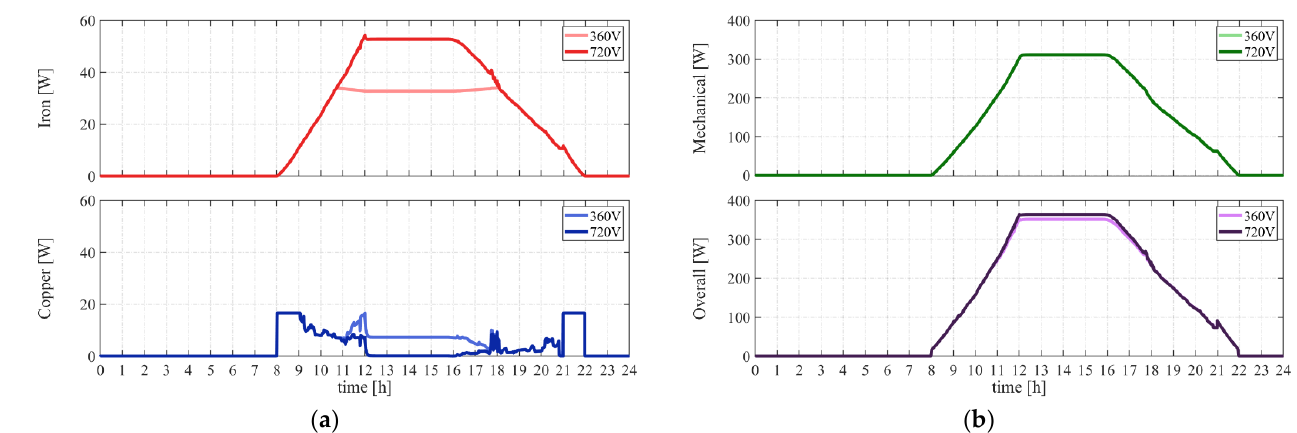
Figure 16. Losses evolutions achieved over a real operating scenario: ( a ) @360 V and ( b ) @720 V (case C1).